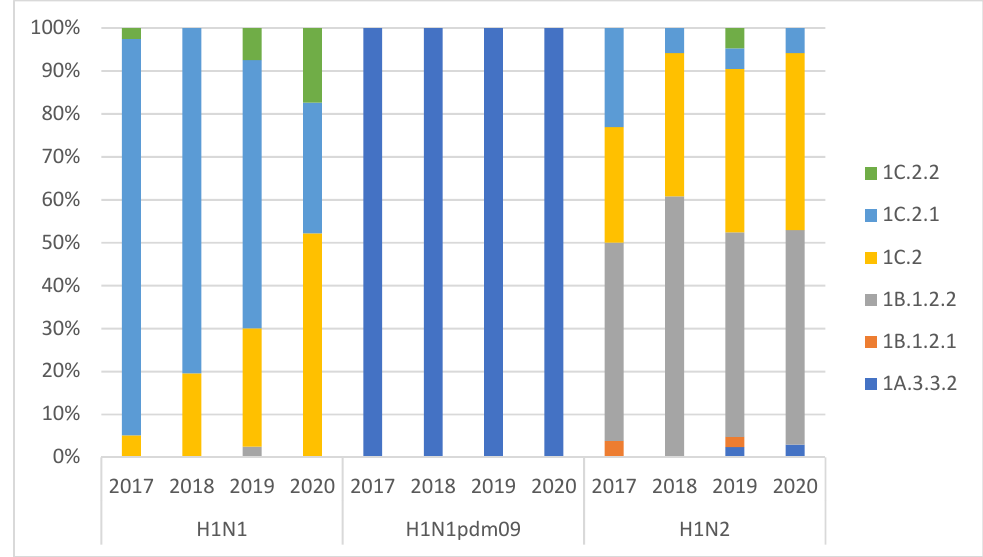
Figure 2. H1 lineage differentiation per year of collection of swIAVs detected. H1 nomenclature was applied as described by Anderson et al. Strains were classified in subtypes: H1N1 (HA-1B/HA-1C- N1), H1N1pdm09 (HA-1A-N1), H1N2 (HA-1A/HA-1B/HA-1C-N2).